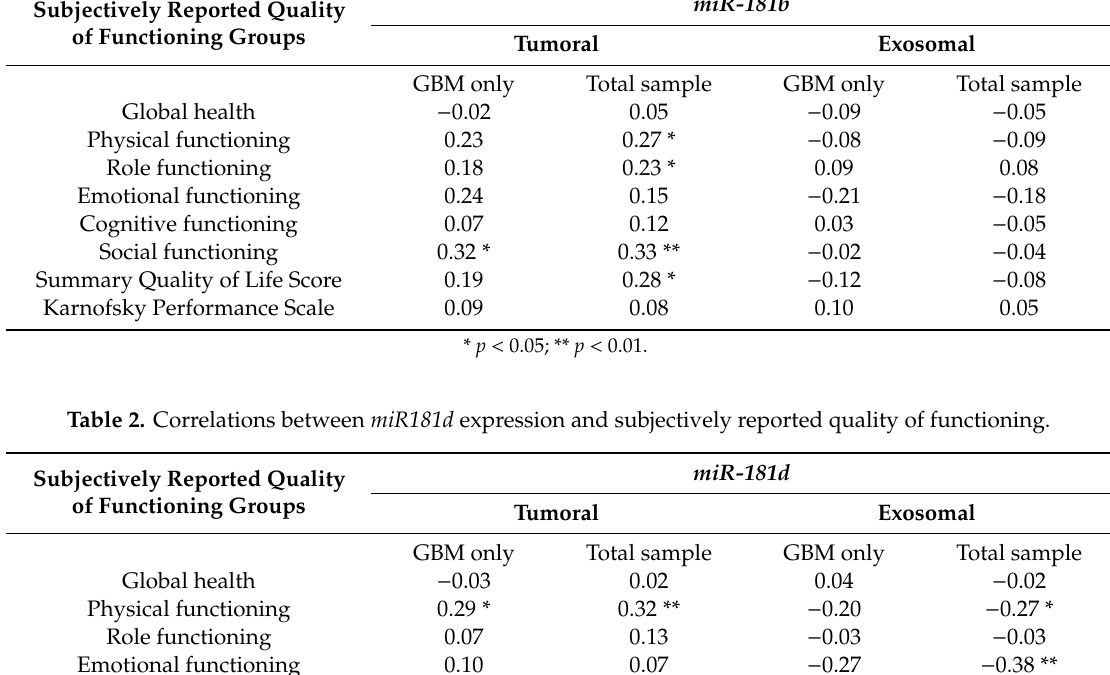
Table 1. Correlations between miR181b expression and subjectively reported quality of functioning. Subjectively Reported Quality